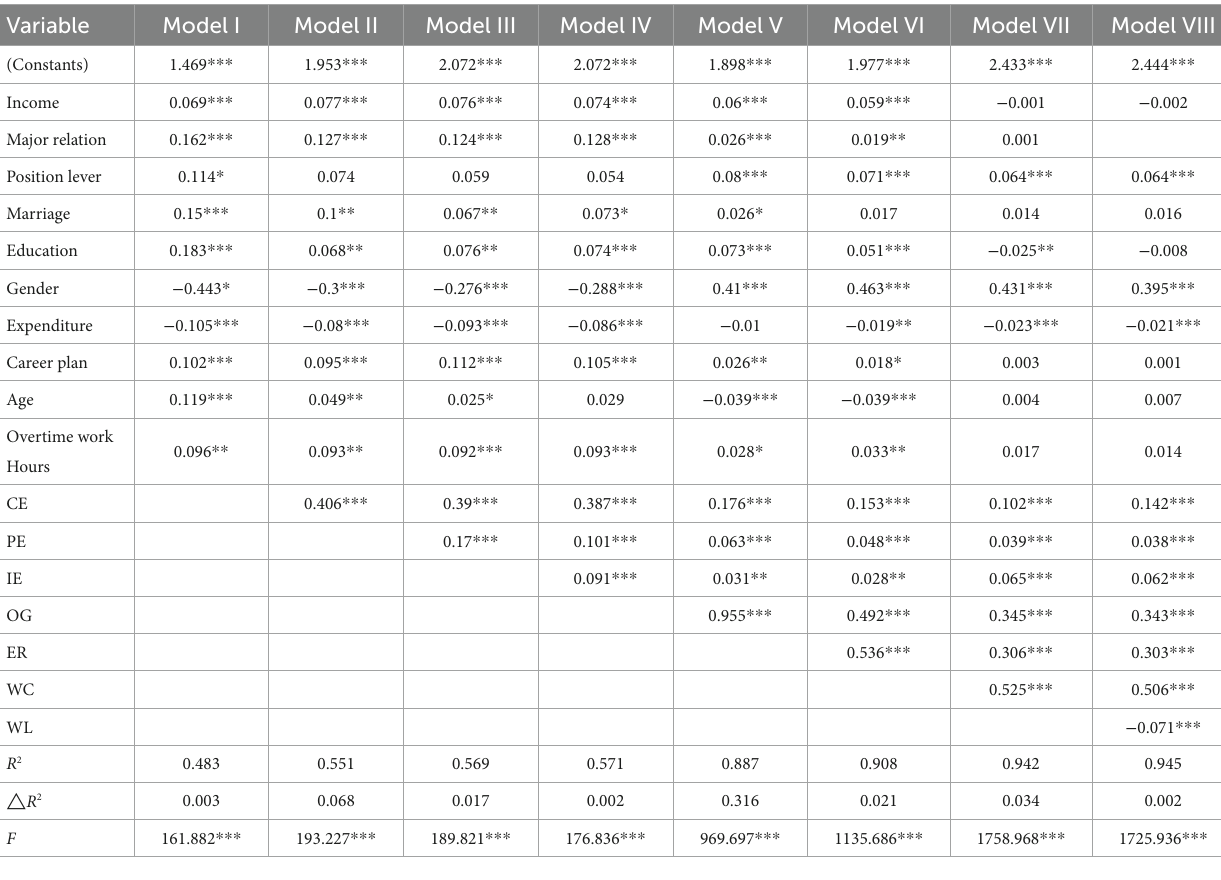
TABLE 7 Model regression analysis 1.